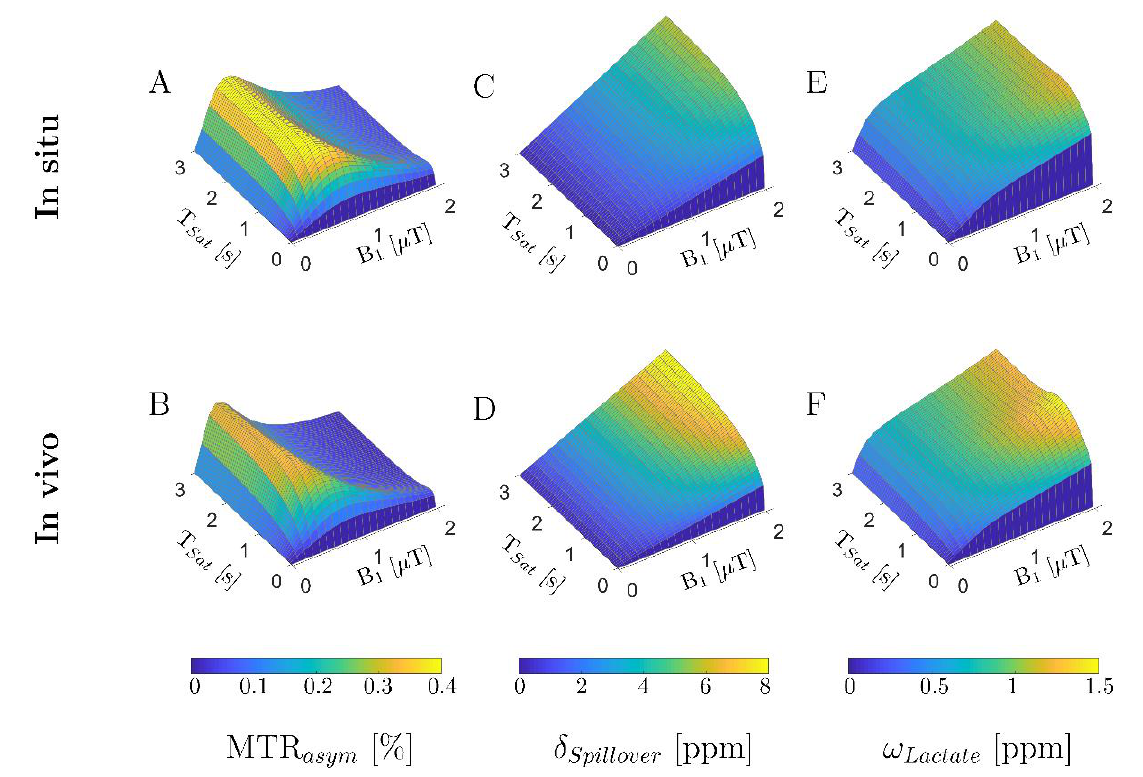
Figure 2. Three-dimensional plots of saturation times (T sat ) and radiofrequency field strengths (B 1 ) using simulation frameworks for in situ (T 1 = 856 ms, T 2 = 69 ms, and k sw = 350 Hz) and in vivo (T 1 = 1412 ms, T 2 = 50 ms, and k sw = 550 Hz) pulse train CEST simulations. ( A , B ) Simulated maximum CEST effect as indicated by MTR asym ; ( C , D ) simulated width of direct water saturation as indicated by δ Spillover ; ( E , F ) location of maximum simulated lactate CEST effect as indicated by ω Lactate